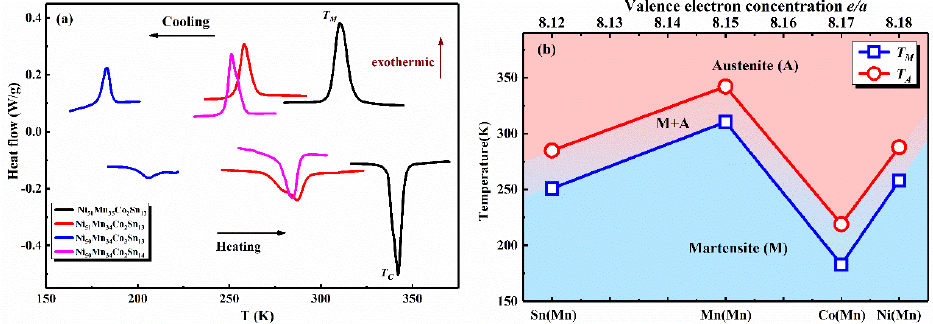
Figure 2. ( a ) The differential scanning calorimetry (DSC) heat flow curves of Ni-Mn-Co-Sn alloys upon heating and cooling with a ramp rate of 10 K/min. ( b ) The martensitic transformation temperature ( T M ) and reverse martensitic transformation temperature ( T A ) as a function of different atomic substitution and valence electron concentration e / a .